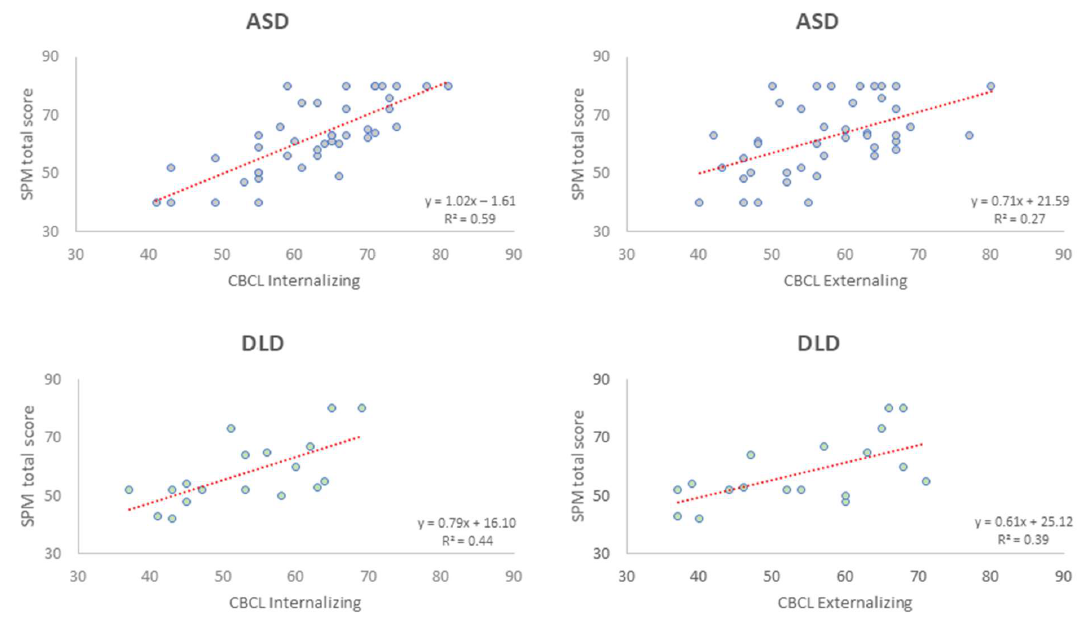
Figure 3. The figure reports the linear regression analysis between SPM total scores and CBCL 1 1 / 2 -5 Internalizing and Externalizing scores for ASD and DLD groups. Dots represent individual par- ticipants; in the case of significant regression, the linear trend is reported as the red dotted line. R and p values are indicated in each panel. For the reader’s convenience, x- and y-axes have been kept homogeneous.